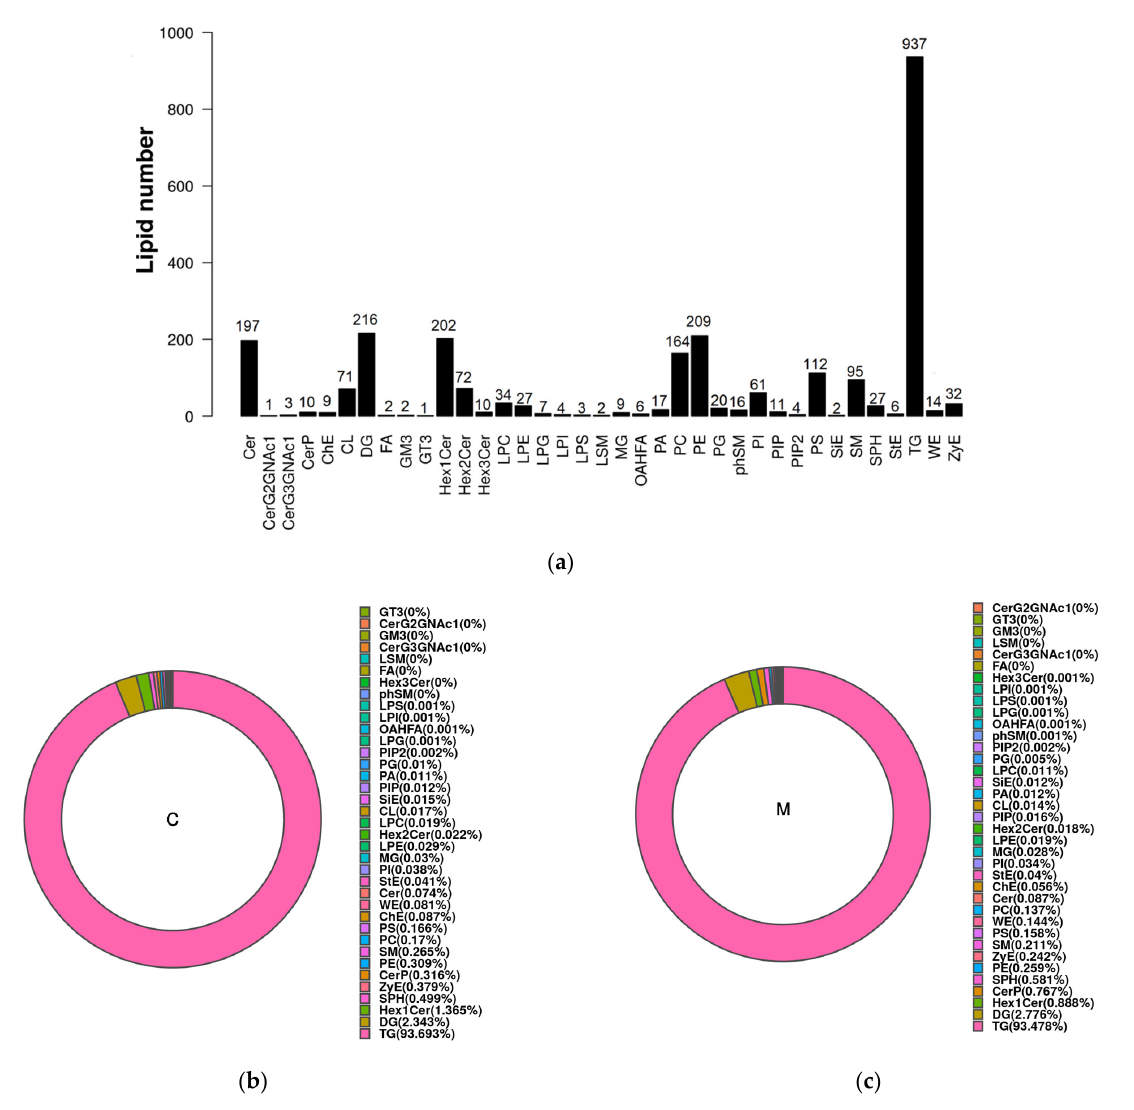
Figure 1. ( a ) Bar chart of the lipid subclasses and molecule numbers in yak milk. The abscissa rep- resents the detected lipid subclass, and the ordinate represents the number of lipid molecules. ( b ) Composition of lipid subclasses in yak colostrum. C: colostrum. Di ff erent lipid subclasses are rep- resented by the di ff erent colors, and the proportion is represented by the area size. ( c ) Composition of the lipid subclasses in yak mature milk. M: mature milk.